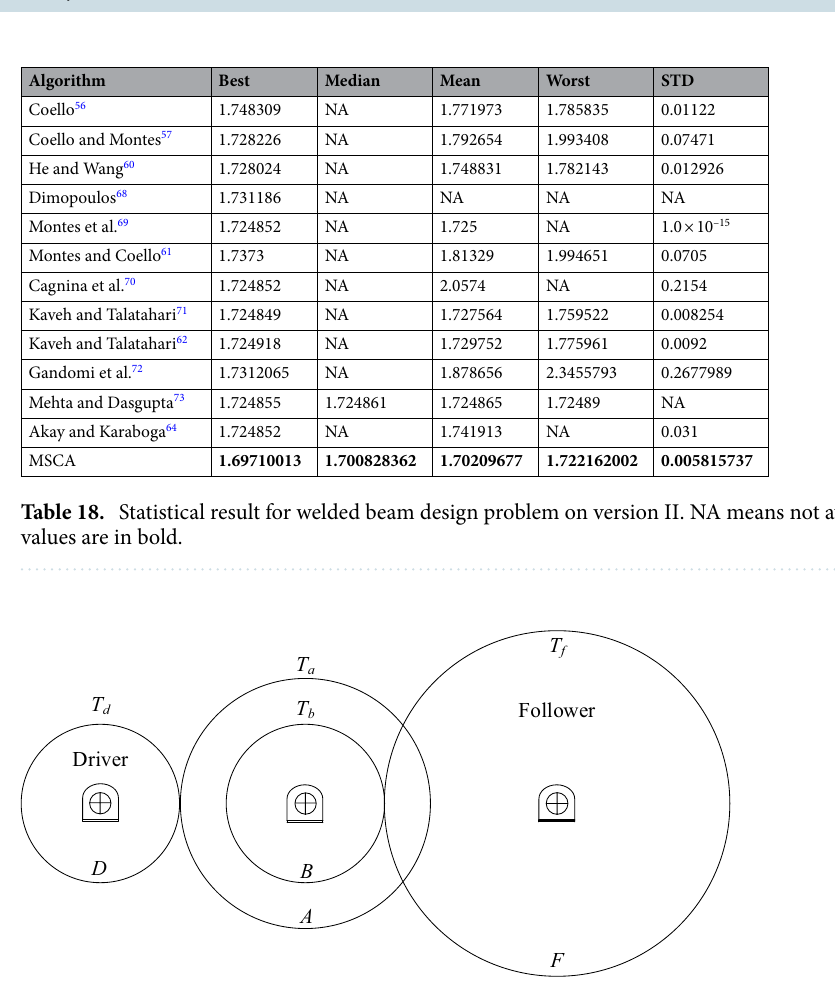
Figure 13. Gear train design.